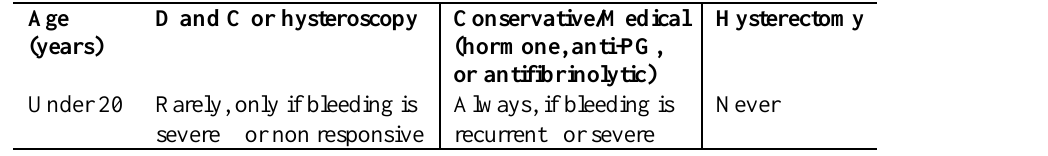
Table VIII : Management strategy in adolescent DUB (Compiled from Sharma JB 29